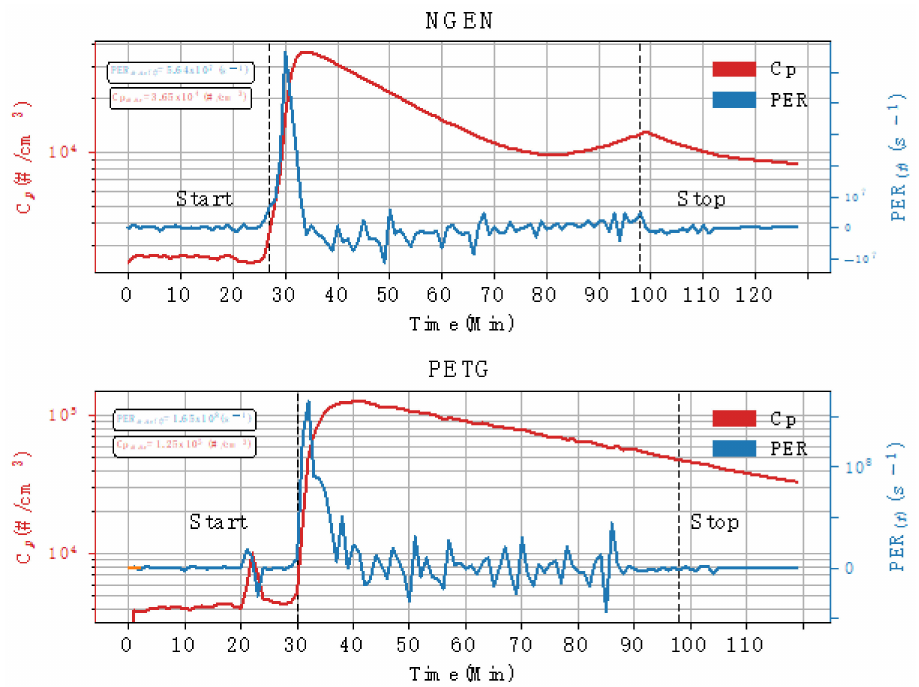
Figure 5. Average particle emission rates (PERs) during printing with polyethylene terephthalate (PETG) and styrene free co-polyester